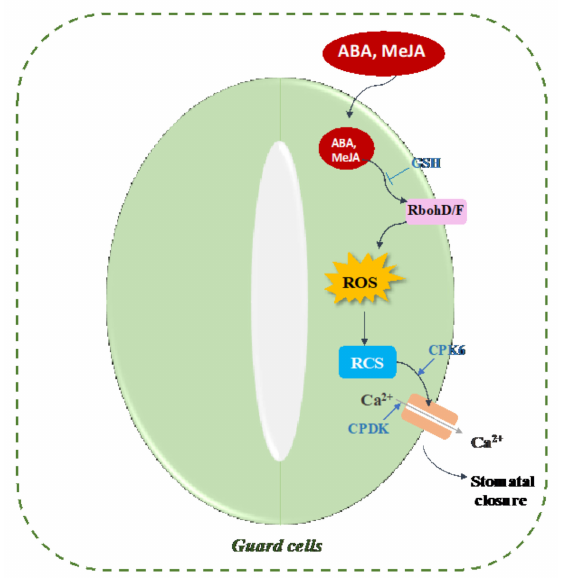
Figure 5. A model of RCS-mediated carbonylation processes in the hormonal signaling pathway in guard cells. ABA or MeJA induced the production of ROS by NAD(P)H oxidases (RbohD and RbohF) located on the plasma membrane in the guard cells. The RCS derived from the oxidation of membrane lipids by ROS trigger the activation of Ca 2+ -permeable cation channels in the plasma membrane, which initiates the elevation of the cytosolic free Ca 2+ concentration through Ca 2+ influx from the apoplast and the intracellular stores. RCS likely induce the carbonylation of an unknown protein target upstream of the calcium channels. CPK6 is a positive regulator of ABA- or MeJA-induced stomatal closure, whereas CDPK6, an isozyme of CPK6, is responsible for the regulation of Ica channels in ABA- or MeJA-induced stomatal closure. The increase in cytosolic Ca 2+ is sensed by CDPKs and CPK6 and results in the activation of the S-type anion channels and stomatal closure. GSH is a negative regulator of ABA or MeJA signaling in the guard cell-induced stomatal closure by depletion of intracellular levels of GSH. This model is based on the previous studies from the literature